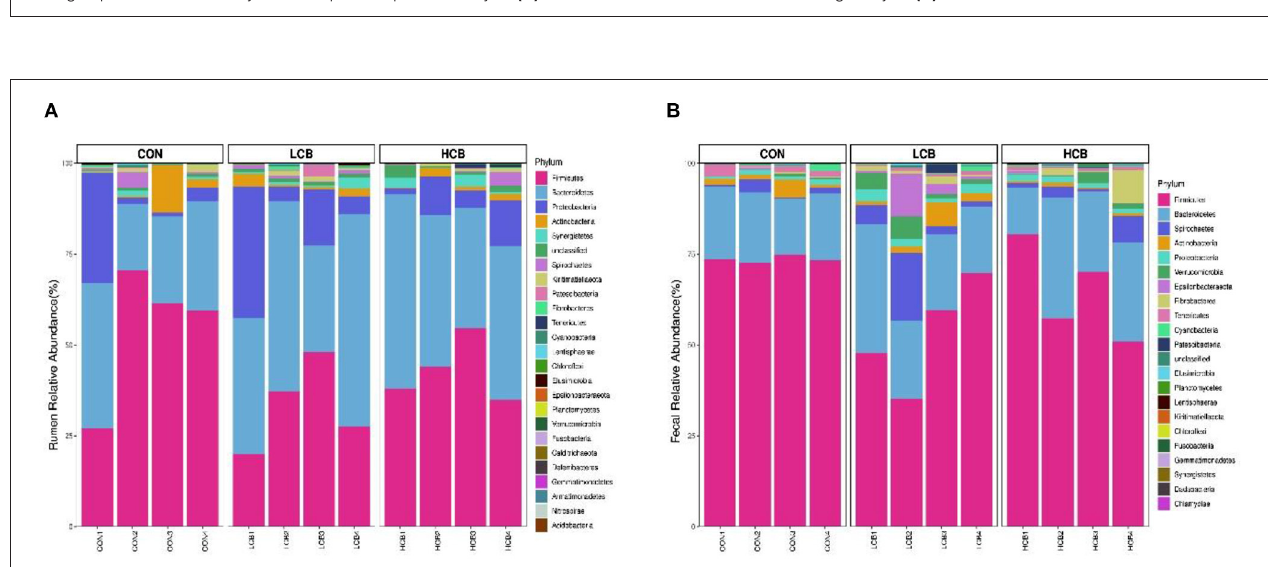
FIGURE 2 | The α - and β -diversity of fecal bacterial communities in fattening goats fed C. butyricum . Shannon (A 1 ) and Simpson (A 2 ) curves of fecal microbiome of fattening goats are shown. Unique and shared rumen feature among CON, LCB, and HCB groups (B) shown on Venn diagrams. Fecal microbial structure among the three groups was estimated by the Principal Component Analysis (C) and Nonmetric Multidimensional Scaling Analysis (D) .